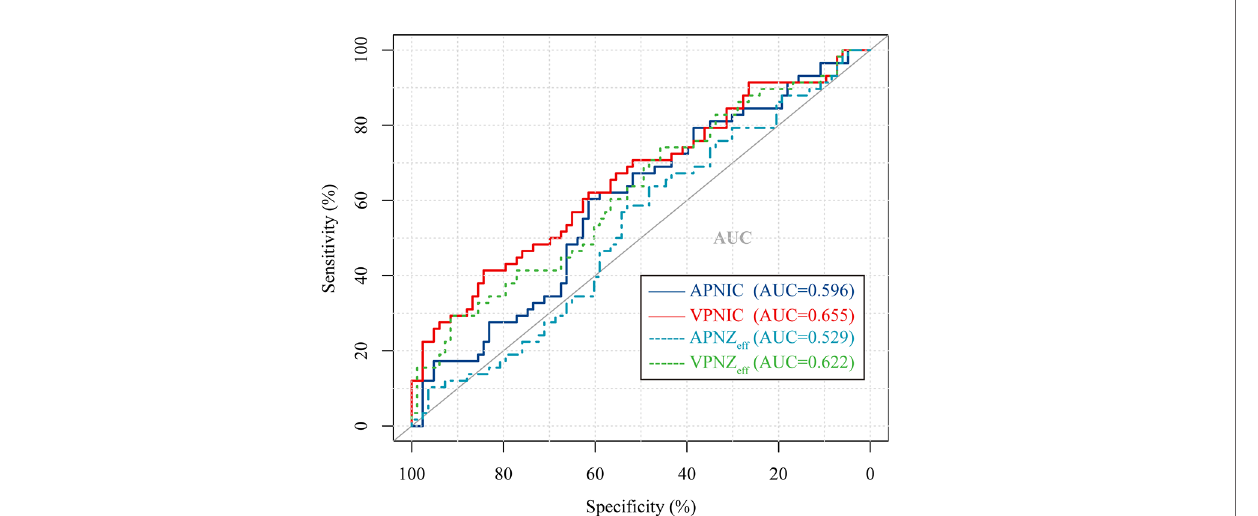
FIGURE 5 | Receiver operating characteristic (ROC) curve of 4 different normalized DECT parameters used to discriminate LNM (+) from LNM (-) in the overall cohort. APNIC, arterial phase normalized iodine concentration; VPNIC, venous phase normalized iodine concentration; APNZ eff , arterial phase normalized effective atomic number; VPNZ eff , venous phase normalized effective atomic number.